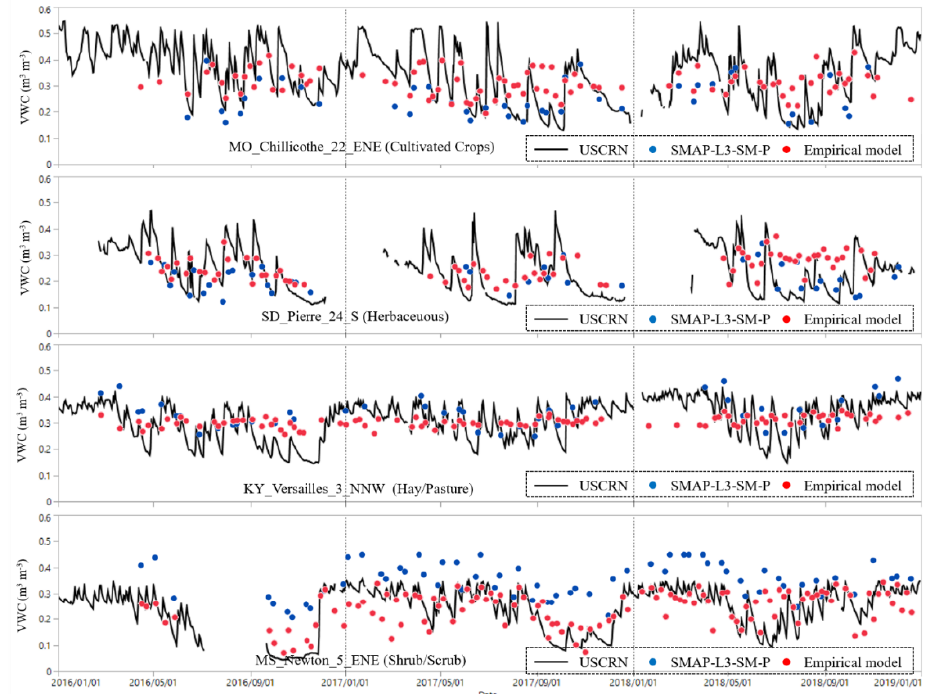
Figure 4. Measured (black line) and predicted soil volumetric water content (VWC, m 3 m − 3 ) using the empirical model (red dots) and SMAP-L3-SM-P (blue dots) at four USCRN stations representing Cultivated Crops (MO_Chillicothe), Herbaceous (SD_Pierre), Hay/Pasture (KY_Versailles), and Shrub/Scrub (MS_Newton) during 2016 – 2018.